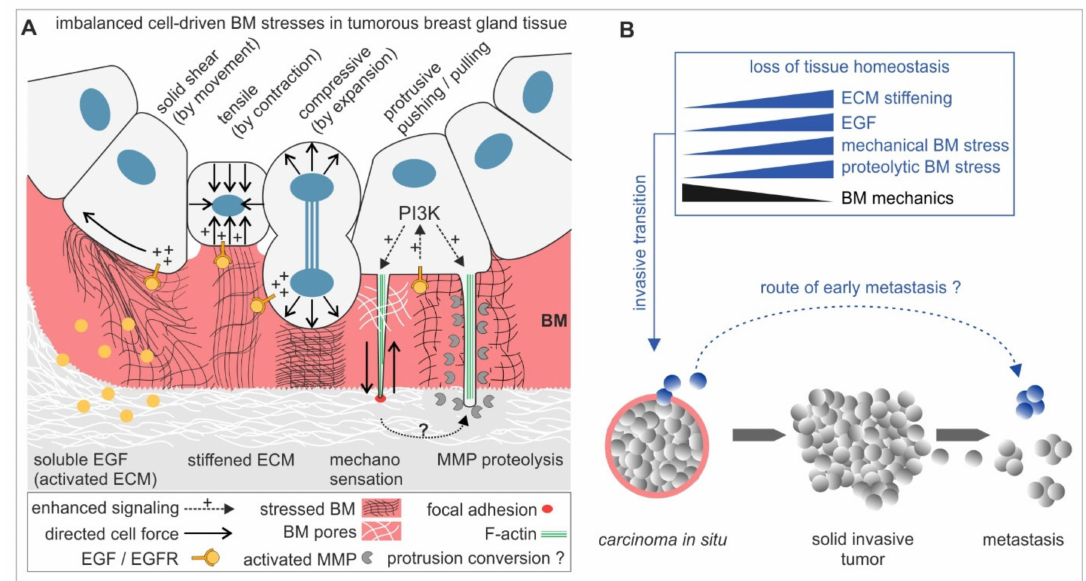
Figure 5. A mechanistic model for BM disruption and invasive dissemination in benign breast gland tissue. ( A ) The mechano-response of non-invasive breast acini to tumour promoting ECM cues activating mechanical and proteolytic stress modes. These modes promote BM-weakening to facilitate invasion synergistically or solely. In the early process of invasive transition, BM mechanics are decisive for stress compensation and to attenuate cell invasion. ( B ) The BM fails to withstand these cellular stresses in progressive tumour microenvironments that induce tissue homeostasis loss. A fraction of benign cells undergoes an invasive transition to transmigrate the locally weakened BM. Finally, this enables a very early tumour cell dissemination and metastasis mode that skips an in situ progression with solid tumour mass expansion and local tissue